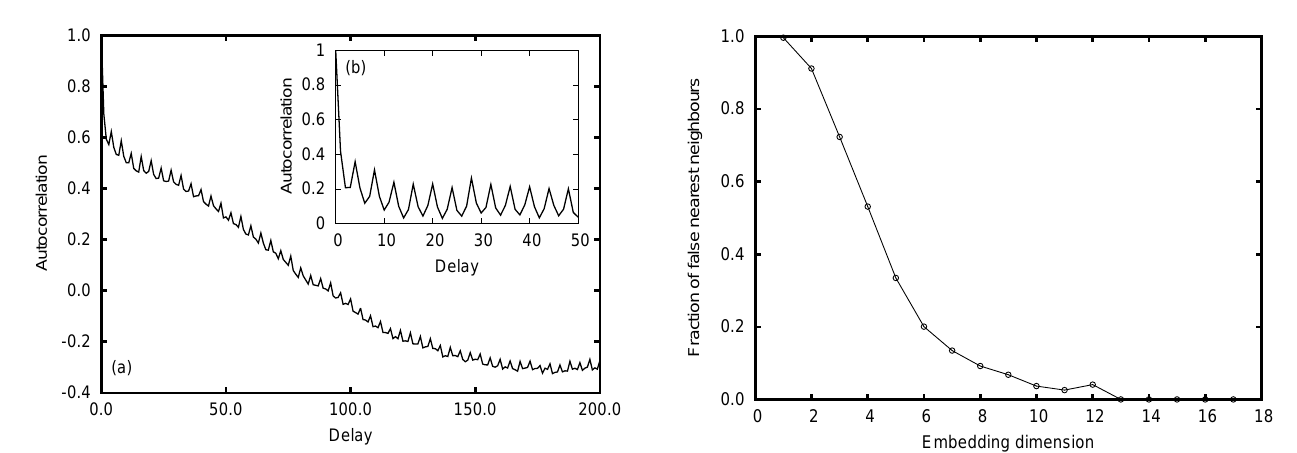
Fig. 5. (a) The autocorrelation function of the observed DMWS data. (b) The autocorrelation function of the detrended time series.